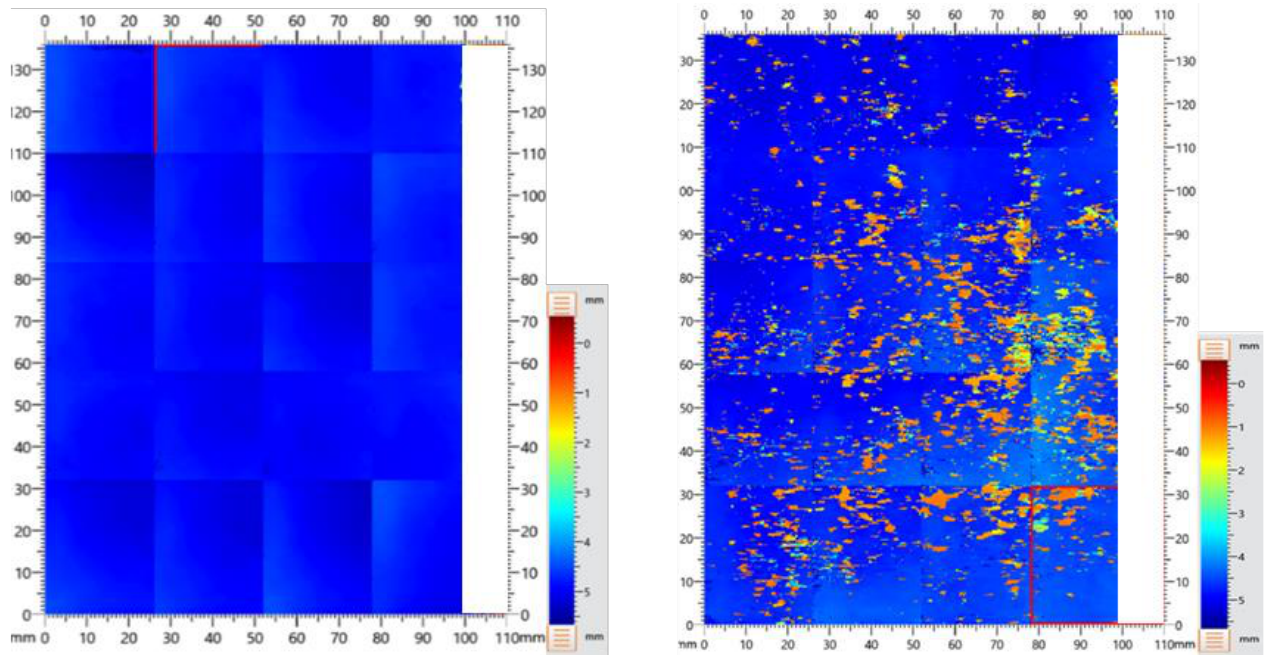
Figure 11. Reference c-scan of a representative RTM6 ( left ) and 3R laminate ( right ).